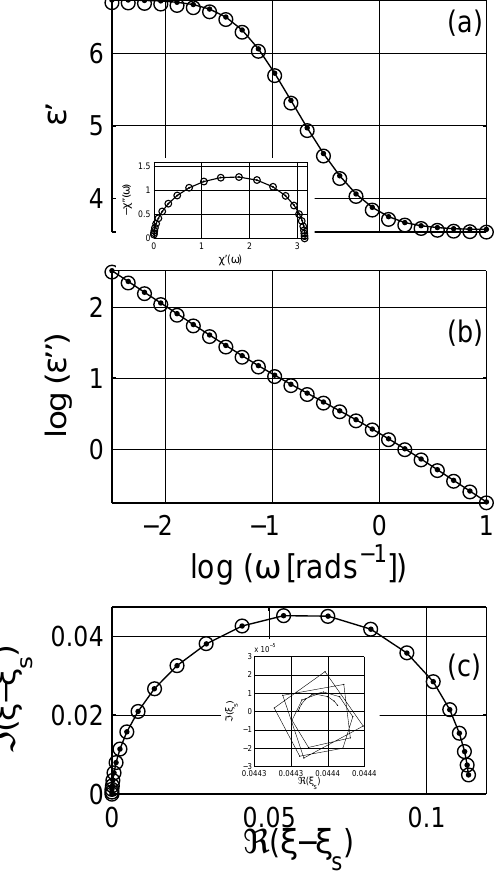
The estimated spectral density functions for two concentration levels, q = 0 . 2 and q = 0 . 3 , are presented in Figure 9. There are six visible peaks, labeled one to six from left to right. (We do not take peak 0 into account in the analysis.) The estimated integrals of portion of the bell-shaped